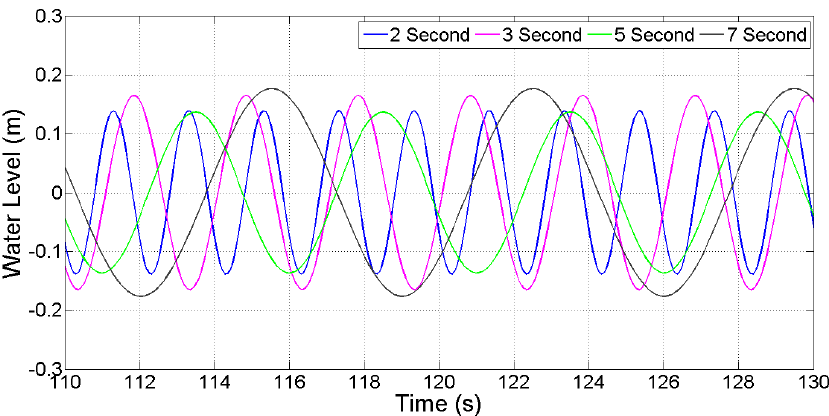
Figure 3. Example incident band water surface elevation timeseries, η i, for each of the four wave periods tested. Prototype scale.